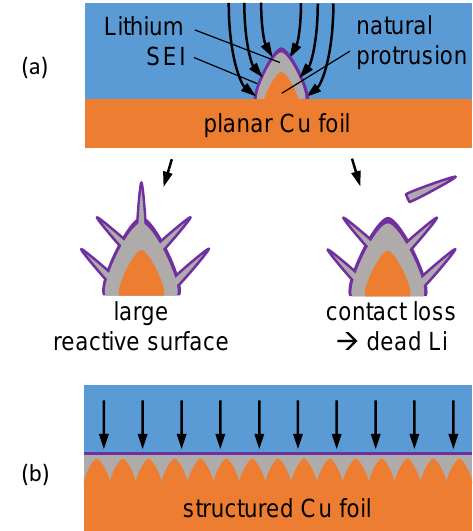
Figure 1. ( a ) Schematic representation of Li deposition on planar Cu foil. Natural protrusions on the surface render inhomogenous Li deposition. ( b ) Structured current collectors with large surface area provide numerous nucleation sites and favor uniform